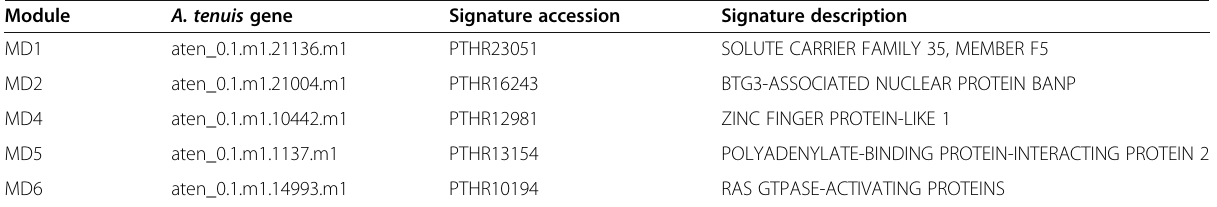
Table 3 Hub genes of each module detected by WGCNA